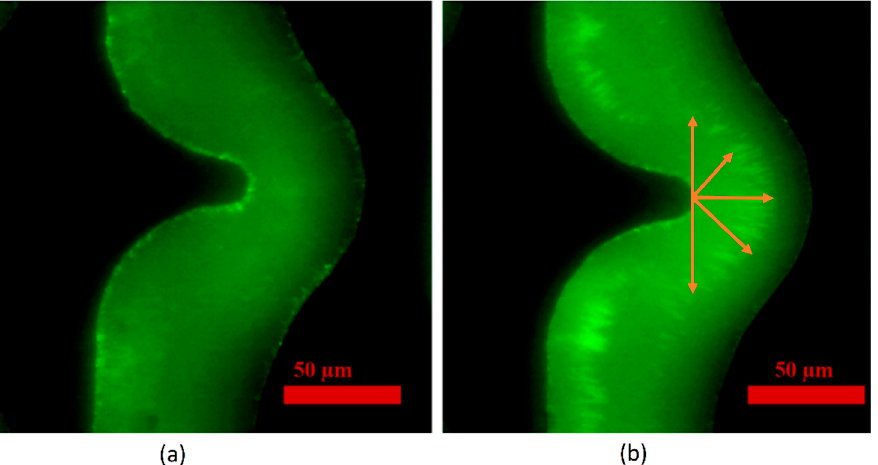
Figure 3. Images used in the calculation of the drift velocity due to negative DEP. ( a ) A single interdigitated electrode pair 60 s after the application of 10 kHz, which produced positive DEP. ( b ) The same electrode pair 80 ms after the application of 500 kHz, which produced negative DEP. The concentration of CA 242 in this solution is 20 U/mL. The interdigitated electrode pair is visible as a darker region in the picture. The bright layer visible on the edge of the electrode was formed by the accumulation of the sample. As the frequency was changed to induce negative DEP, the antigen-bound PM was repelled from the electrode. The scale bar in both figures indicates 50 µm.